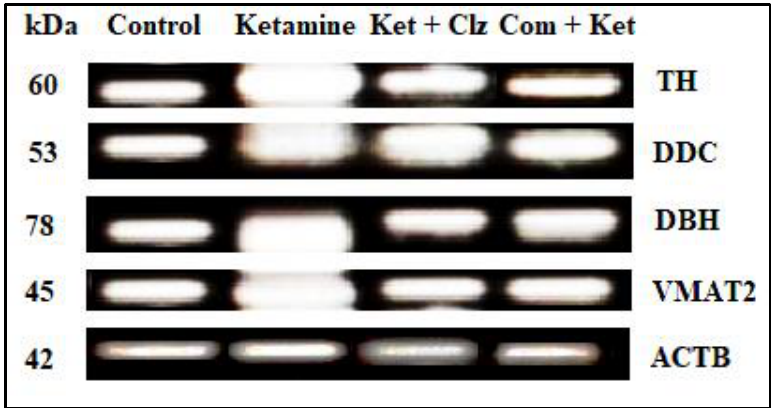
Figure 9. Effects of plant compound and clozapine on the expression of DOPA genes during ketamine treatment in vitro. TH: Tyrosine hydroxylase. DDC: Dopamine decarboxylase. DBH: Dopamine beta hydroxylase. VMAT2: Vesicular monoamine transporter 2 . ACTB: β -actin (internal control).